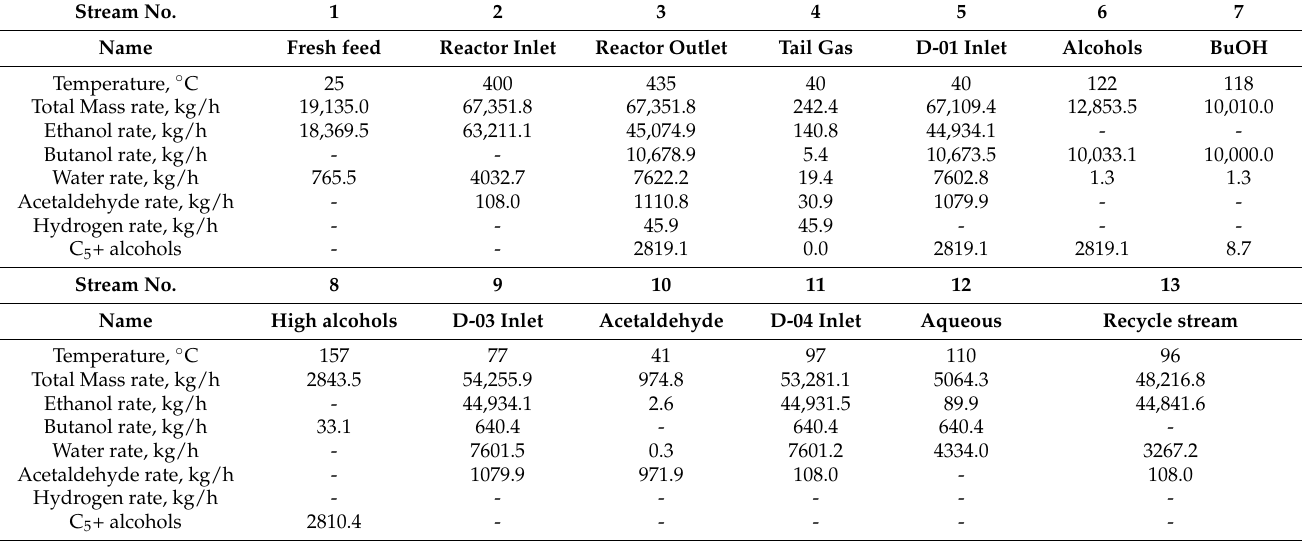
Figure 12. Schematic description of the process for production of 1-butanol from hydrous bioethanol. Table 6. Mass rates of all streams and